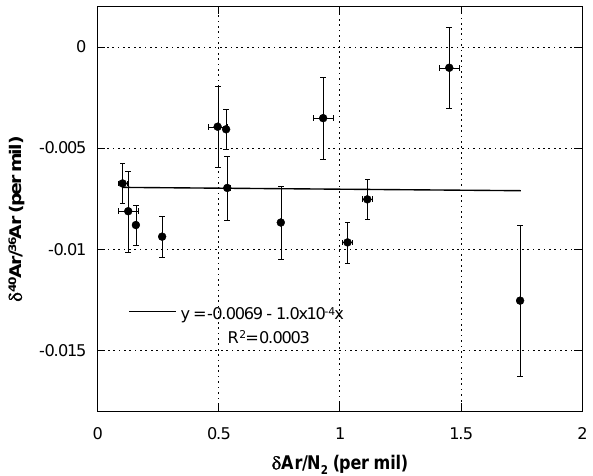
Fig. 7. Isotopic ratios of O 2 as a function of O 2 abundance in the lock-in zone. All data have been corrected for gravitational settling. Data are plotted both with (solid points) and without (empty points) correction for the estimated change in atmospheric O 2 . The solid line is a linear geometric-mean fit to the data, whose slope corre- sponds to a 5 . 8‰ fractionation (see Appendix